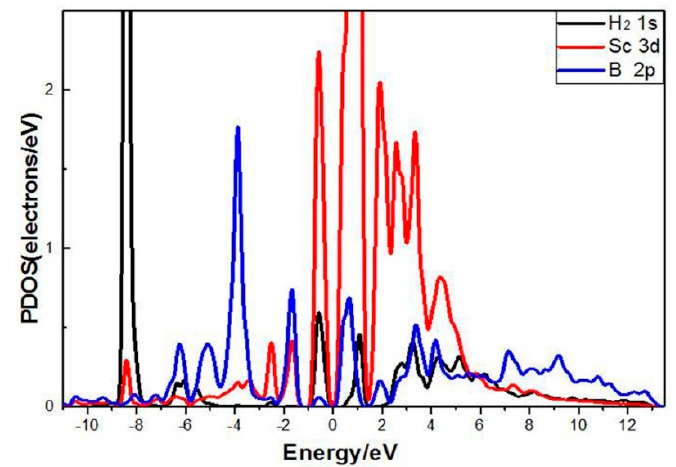
Figure 6. PDOS of Sc-decorated B-PG with one H 2 molecules adsorbed.